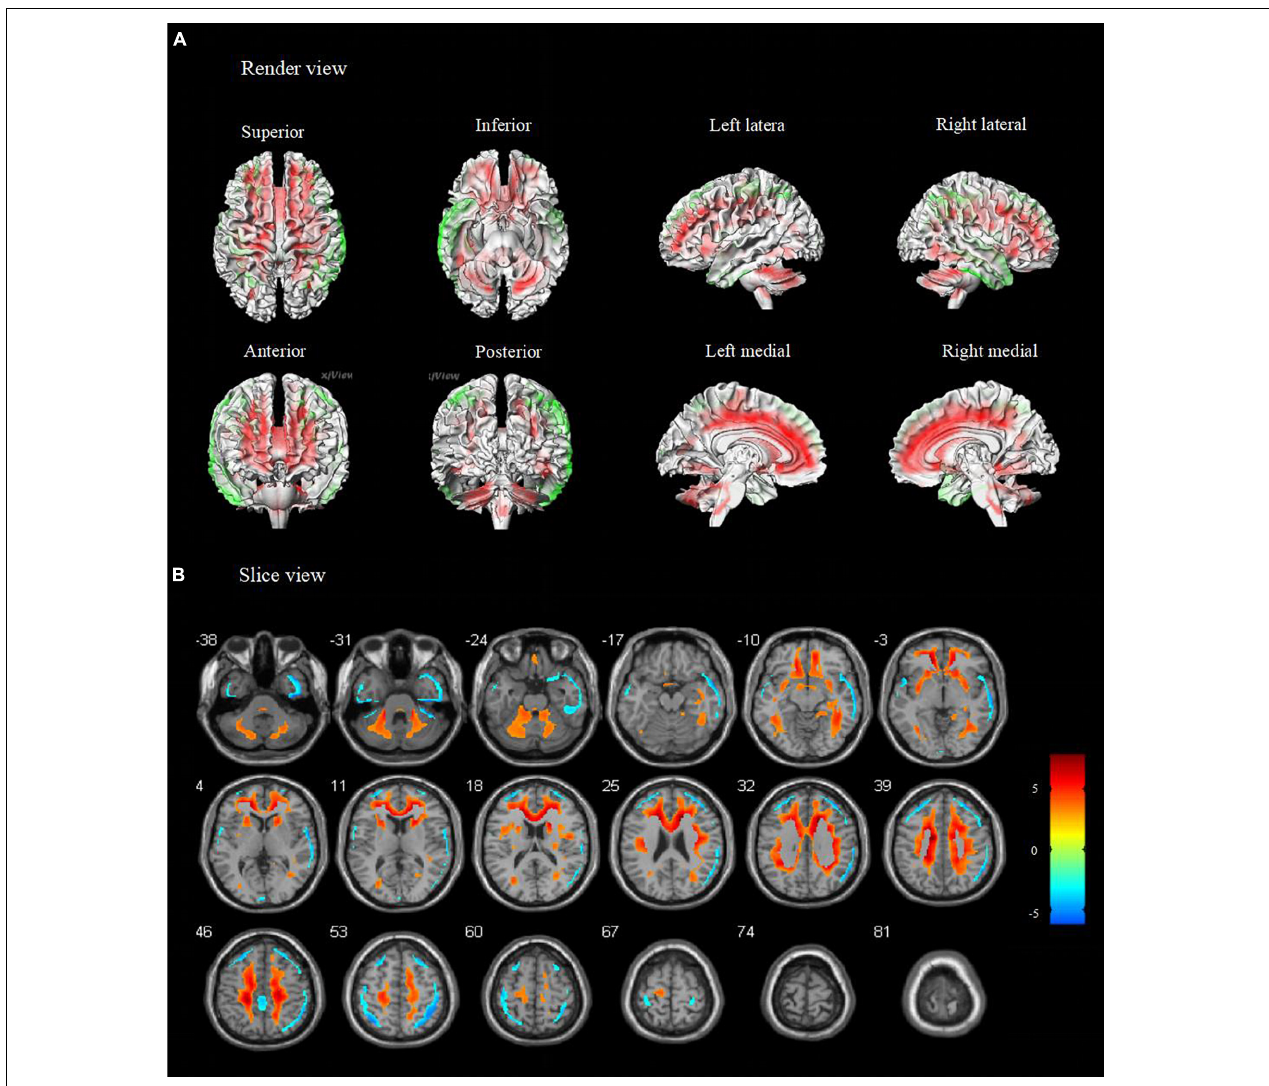
FIGURE 2 | Metabolic features in temporal lobe epilepsy with impaired awareness seizures (FDR corrected). Comparison of temporal lobe epilepsy with awareness impairing seizures ( N = 76) versus healthy controls ( N = 60) was performed in (A) render view and (B) slice view (FDR corrected p < 0.05 with cluster thresholding, k = 20 voxels). Voxels with significantly low uptake are shown in green and voxels with significantly high uptake are shown in